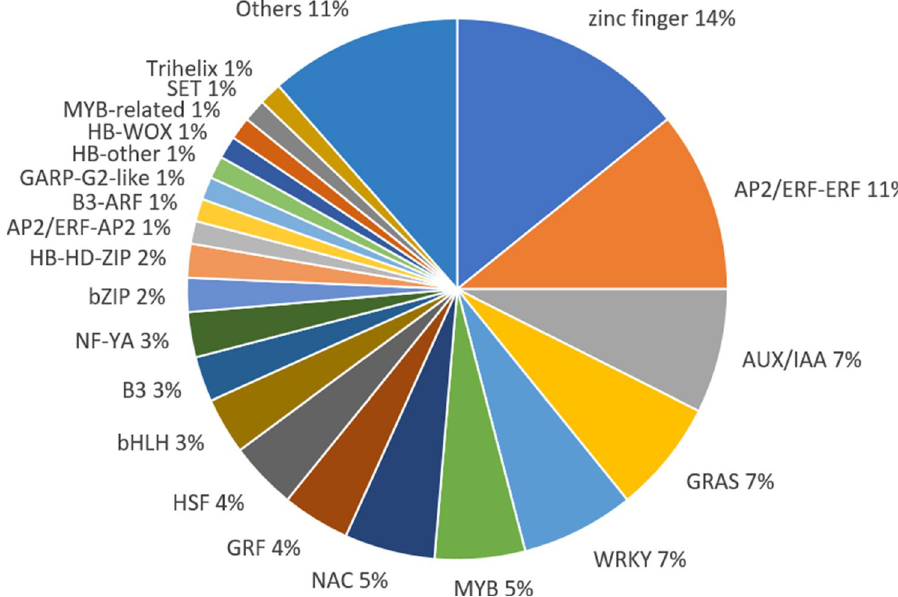
Figure 3. Differentially expressed TF/TR genes and classification of TF/TR families.